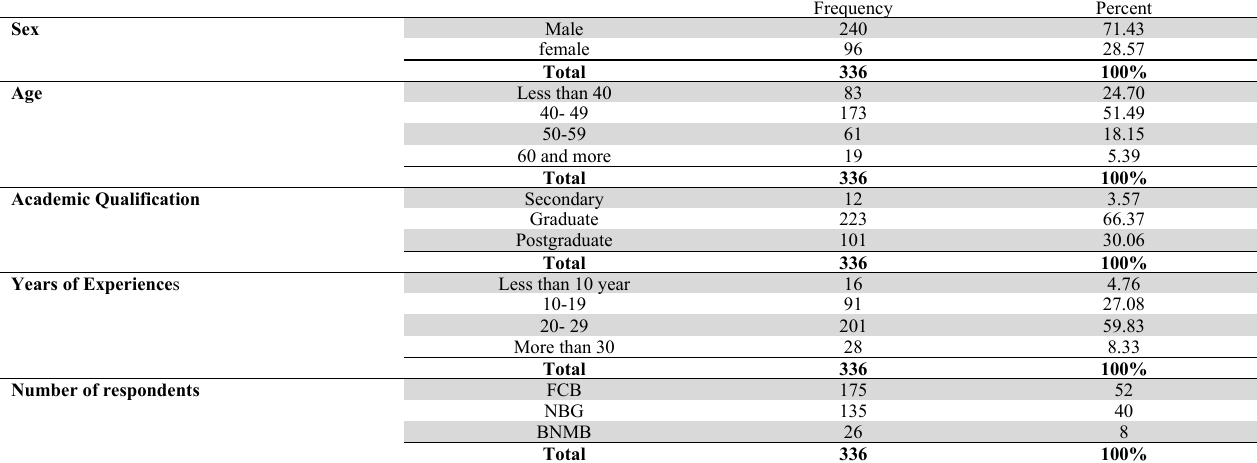
Demographic profile of the study